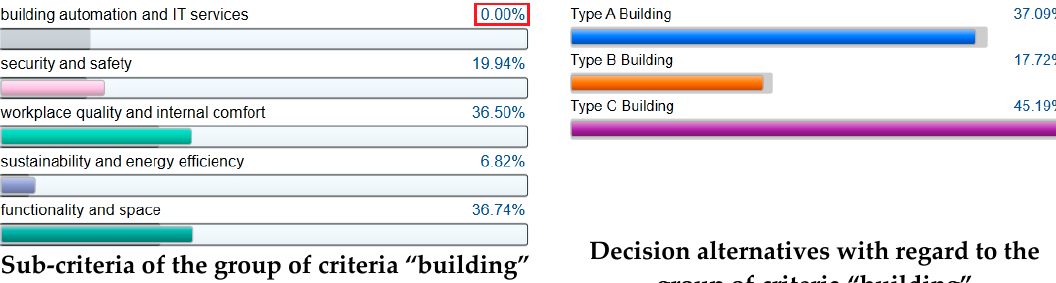
Figure 5. Relevance ranking (%) of sub-criteria of the group of criteria “building” with regard to the choice of adequate office space for BPO tenants with “building automation and IT services” ranked at 0%.